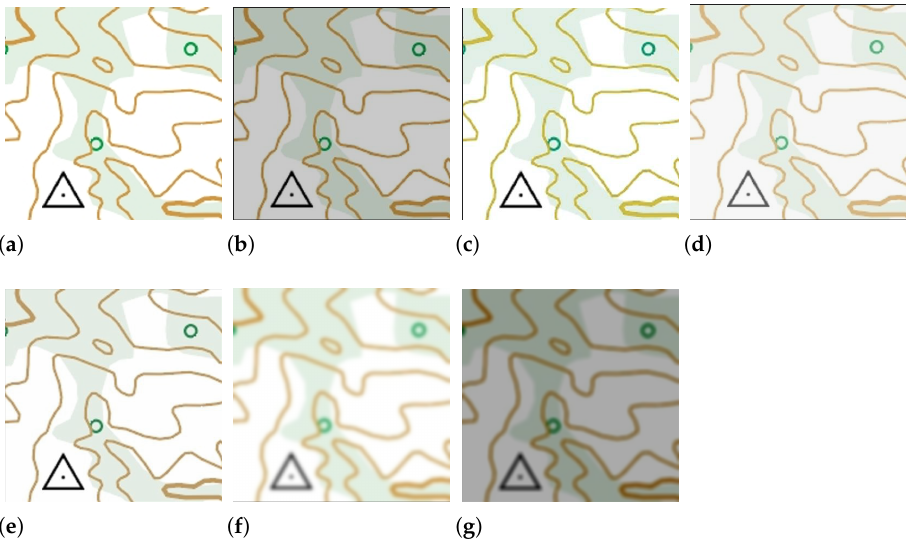
Figure 11. Images obtained by applying the Gaussian blur combined with color jitter method to the original image ( a ): ( b ) brightness transformation, ( c ) hue transformation, ( d ) contrast transformation, ( e ) saturation transformation, ( f ) Gaussian blur, and ( g ) Gaussian blur combined with color